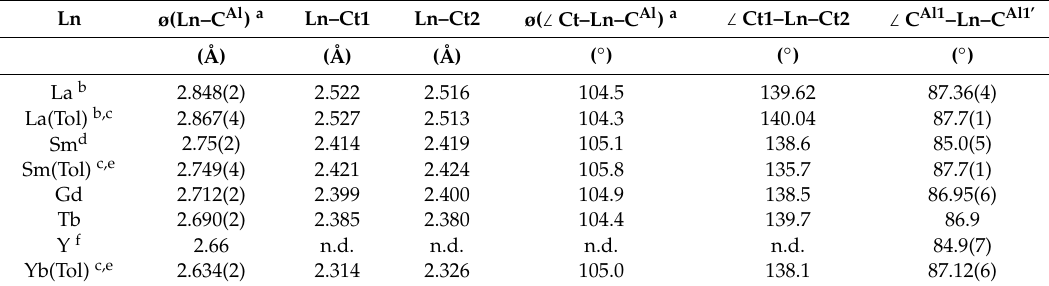
Figure 5. Panel ( a ): ORTEP view of the crystal structure of [Cp* 2 Tb(AlMe 4 )] 2 ( 4 Tb ). Atomic displacement parameters are set at the 50% probability level. Hydrogen atoms and one molecule of n -hexane per asymmetric unit are omitted for clarity. See Table 6 for significant bond lengths and angles. Panel ( b ): ORTEP view of the crystal structure of [Cp*TbMe 2 ] 3 ( 2 Tb ). Atomic displacement parameters are set at the 50% probability level. Hydrogen atoms are omitted for clarity. See Table 3 for significant bond lengths and angles. Table 6. Comparison of selected metrical data of known [Cp* 2 LnAlMe 4 )] 2 ( 4 Ln